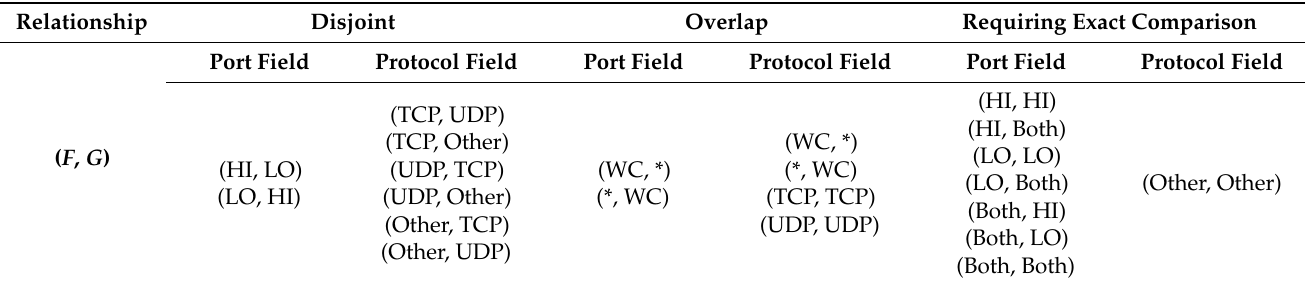
Table 7. All comparison combinations of two filters F and G in a single non-prefix